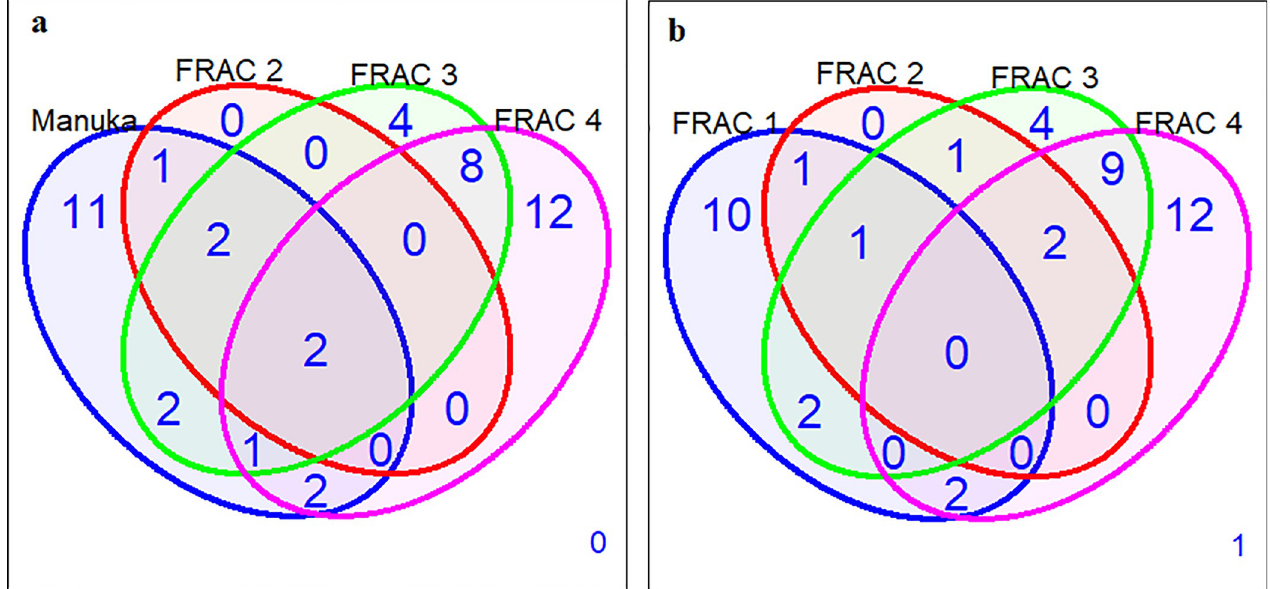
Fig 1. Venn diagram summarizing the overlap of chemical constituents between manuka ( L . scoparium ) essential oil and its fractions.